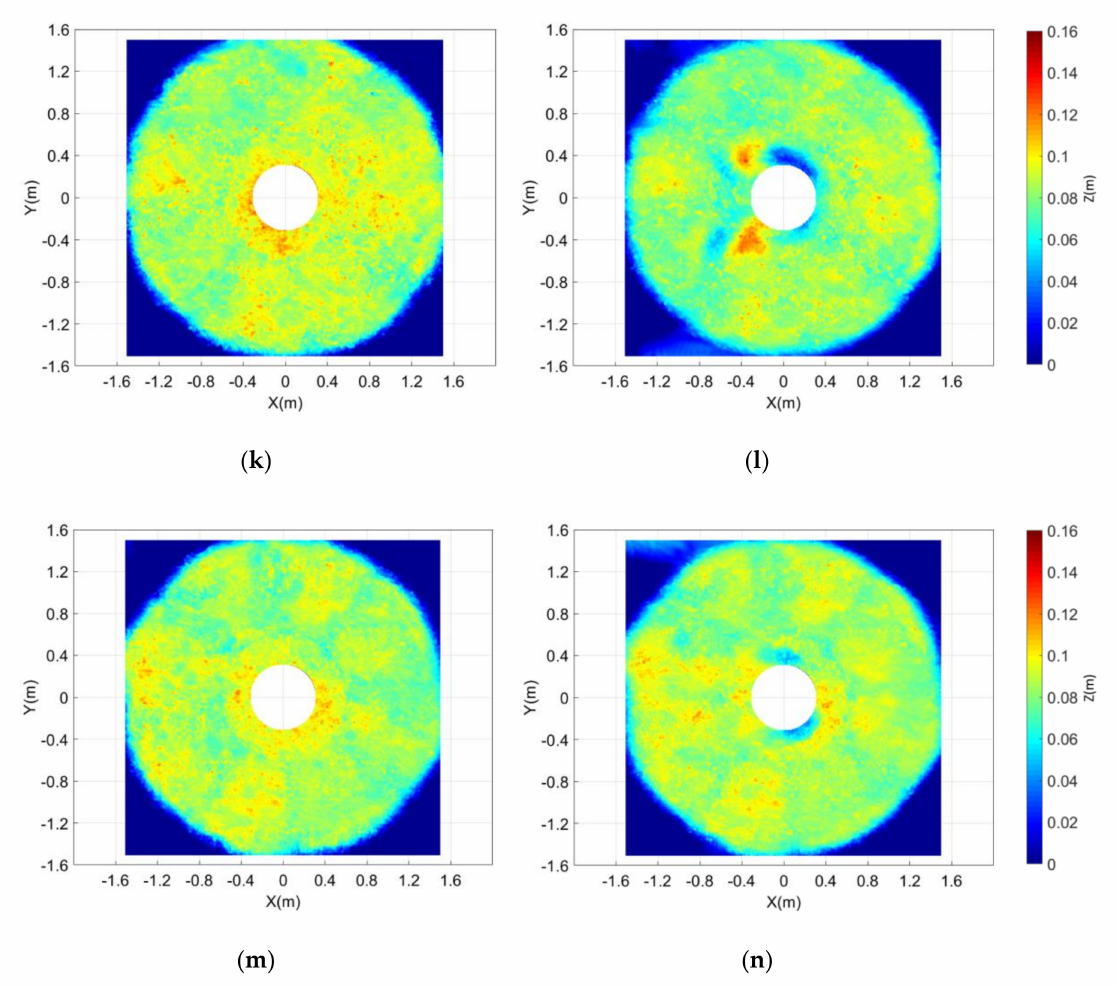
Figure 11. Scanned profiles of the scour protection layer before and after 3000 waves: ( a ) Test 02B before waves; ( b ) Test 02B after 3000 waves; ( c ) Test 04B before waves; ( d ) Test 04B after 3000 waves; ( e ) Test 06B before waves; ( f ) Test 06B after 3000 waves; ( g ) Test 08B before waves; ( h ) Test 08B after 3000 waves; ( i ) Test 10B before waves; ( j ) Test 10B after 3000 waves; ( k ) Test 12B before waves; ( l ) Test 12B after 3000 waves; ( m ) Test 13B before waves; ( n ) Test 13B after 3000 waves. The Stab parameter (Equation (5)) and the measured and predicted S 3 D (Equations (8) and (9)) values are also given in Table 5. For the present cases, the Stab parameter is always less than 0.4. The protection layer is assumed to be statically stable [17]. However, it can be seen that most of the presented results are clearly not statically stable but dynamically stable. This shows the design limitation of using the predicted Stab parameter as an underestimation of the damage level. A comparison is made between predicted and measured S 3 D values after 3000 waves as shown in Figure 12. It can be noted that the predicted damage numbers are almost larger than the measured damage numbers, regardless of whether waves are following or opposing current. It is defined by De Vos et al. (2012) [19] that failure occurs when the estimated damage number is larger than 1. However, despite Test 08B, no clear failure is seen in Test 02B, 04B, 06B, 10B, 12B, and 13B, despite the predicted damage numbers S 3 D , pred being larger than 2. For Test 08B, the damage pattern shows a clear horseshoe vortex induced by the current, causing a large exposure area of the geotextile. The high damage number is mainly due to the high current condition, the small stone material, and a lower protection layer